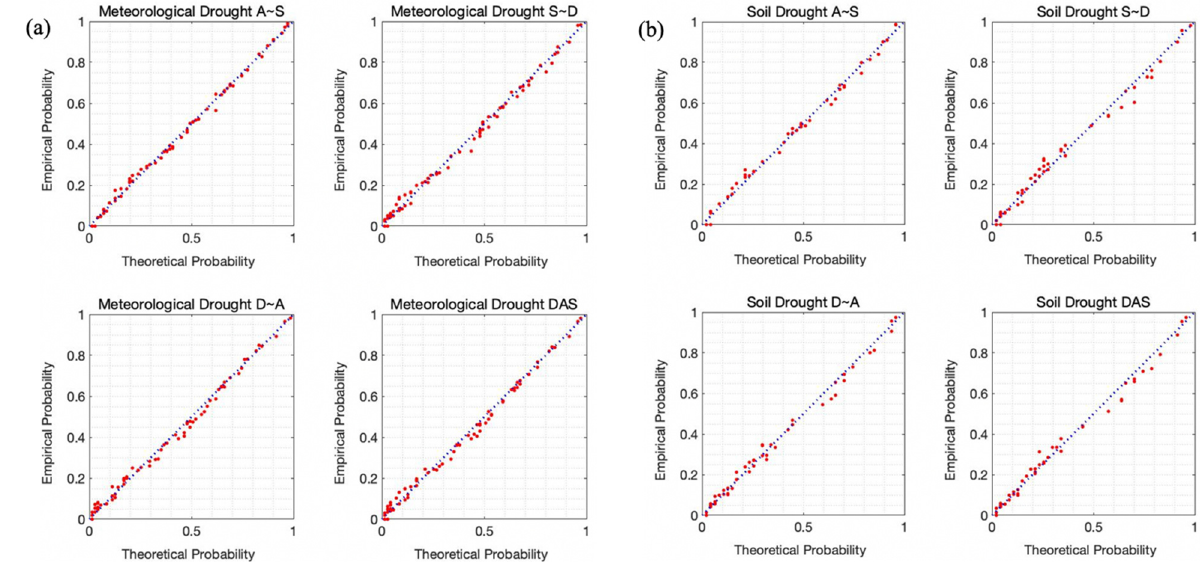
Figure 3. The fitting results of the copulas. ( a ) refers to the fit result of meteorological droughts, and ( b ) refers to the fit result of soil droughts. The x -axis is the cumulative probability estimated by the distribution functions, and the y -axis is the cumulative probability estimated by empirical functions. Table 2. The goodness of fits in the